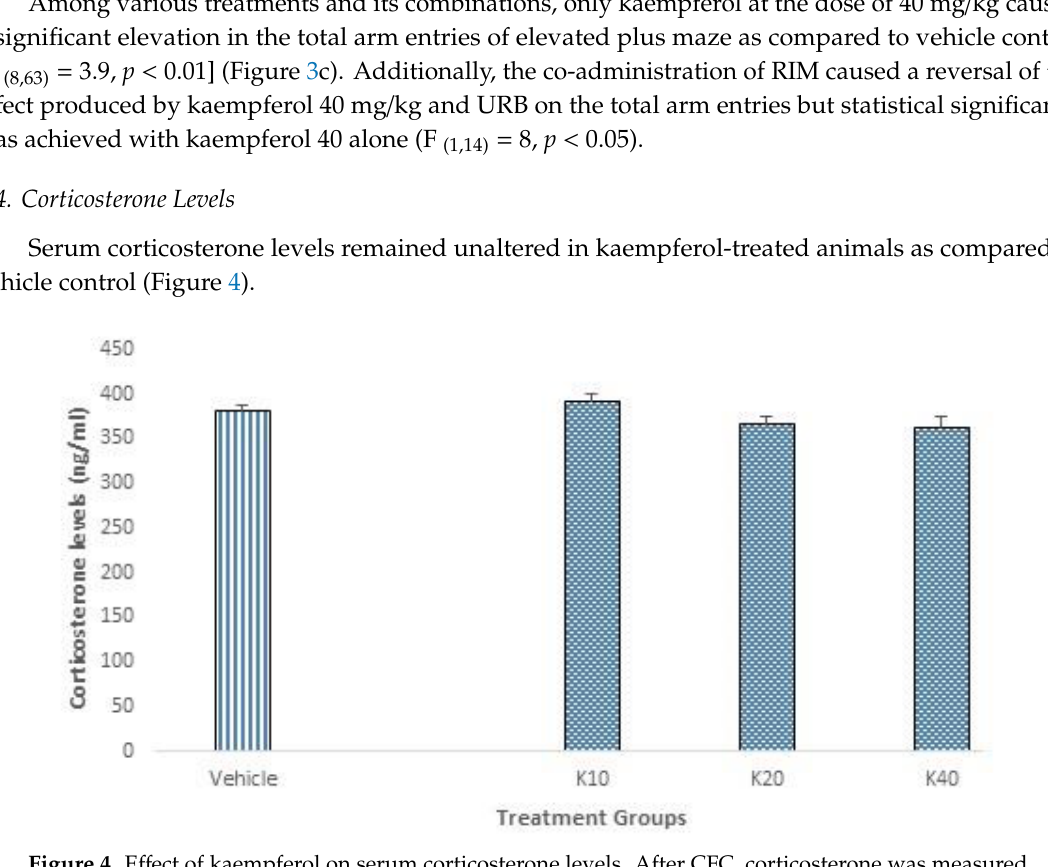
Figure 4. E ff ect of kaempferol on serum corticosterone levels. After CFC, corticosterone was measured in the serum using an ELISA kit. No significant change was noted. Data is represented as mean ± S.E.M. K10, 20, 40 (kaempferol 10, 20 or 40 mg/kg).